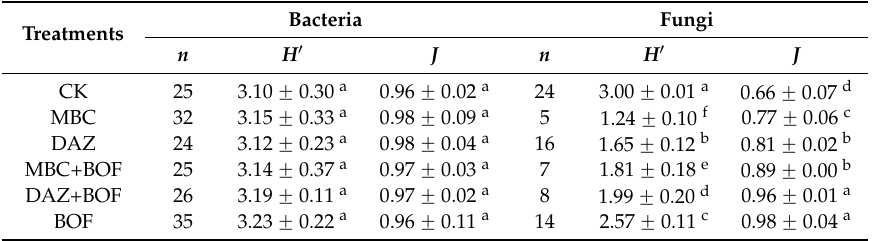
Table 3. Shannon diversity ( H' ) and equitability ( J ) indices of the soil microbiota in response to the various soil treatments. The indices and number of fragments ( n ) were determined from DGGE profiles. Data given in the form mean ˘ SE ( n = 3) *.